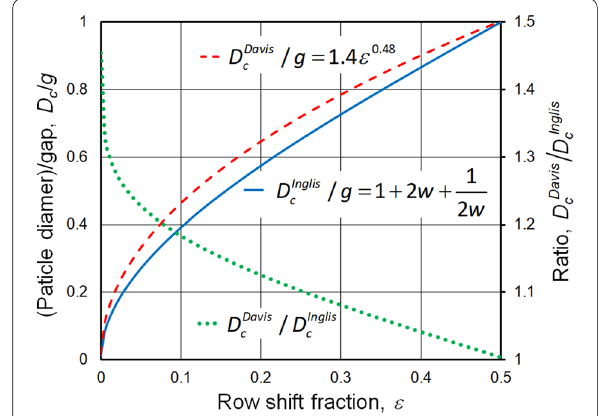
Fig. 2 Theoretical and empirical points of the particle diameter divided by the gap, versus the row shift fraction, ε (primary axis); the ratio between theoretical and empirical critical diameters (secondary